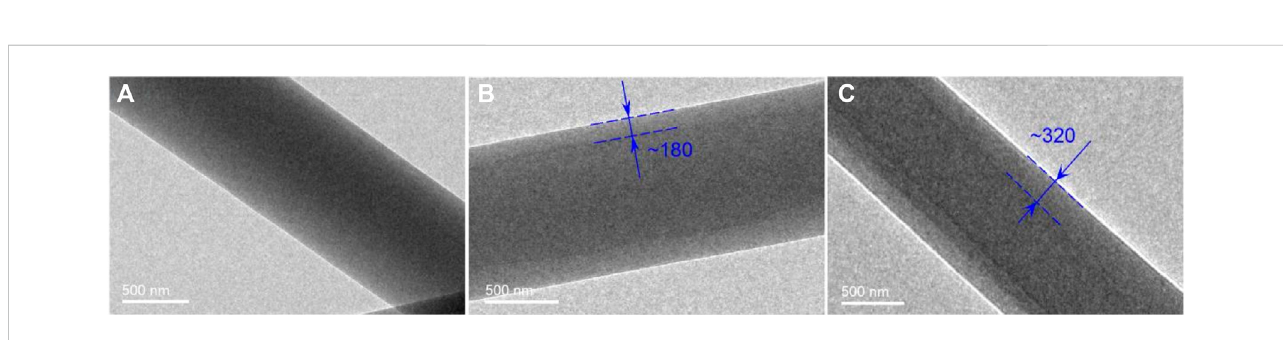
FIGURE 5 TEM images of the electrospun nano fi bers: (A) S1; (B) S2; (C)